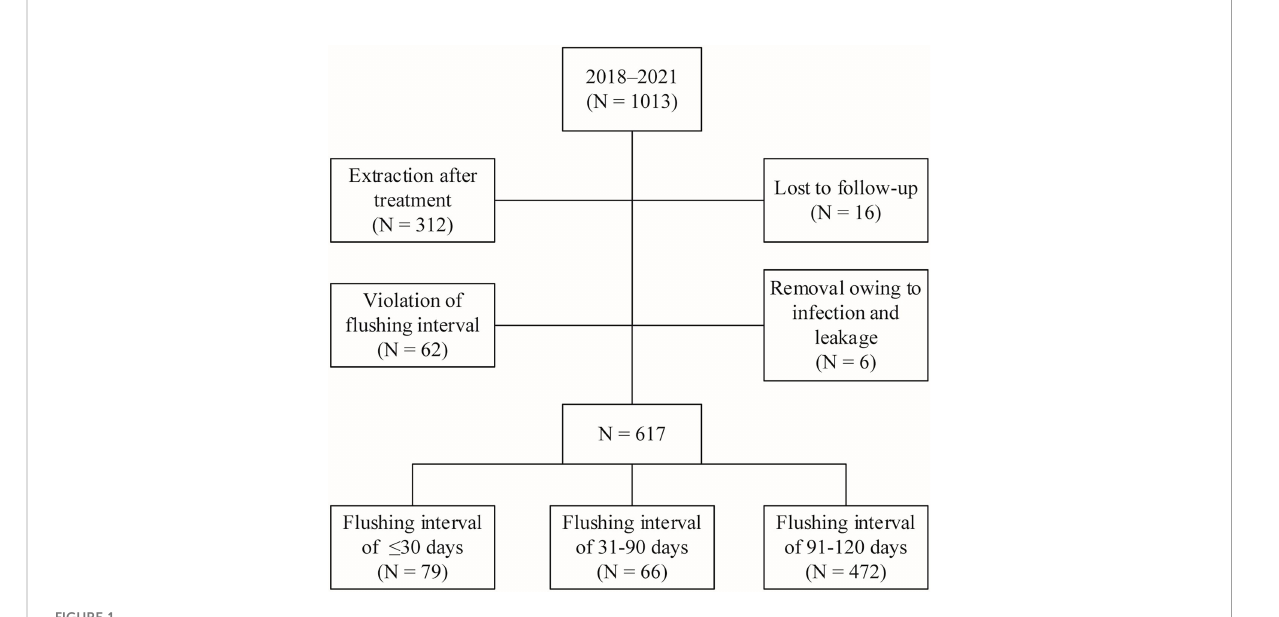
FIGURE 1 Flow chart of the study